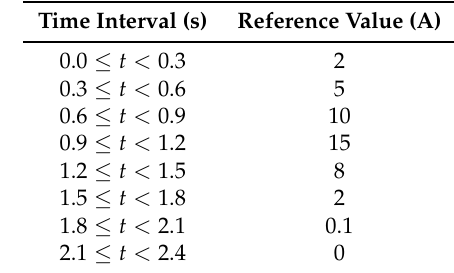
throughout the time of the simulation. G2V b